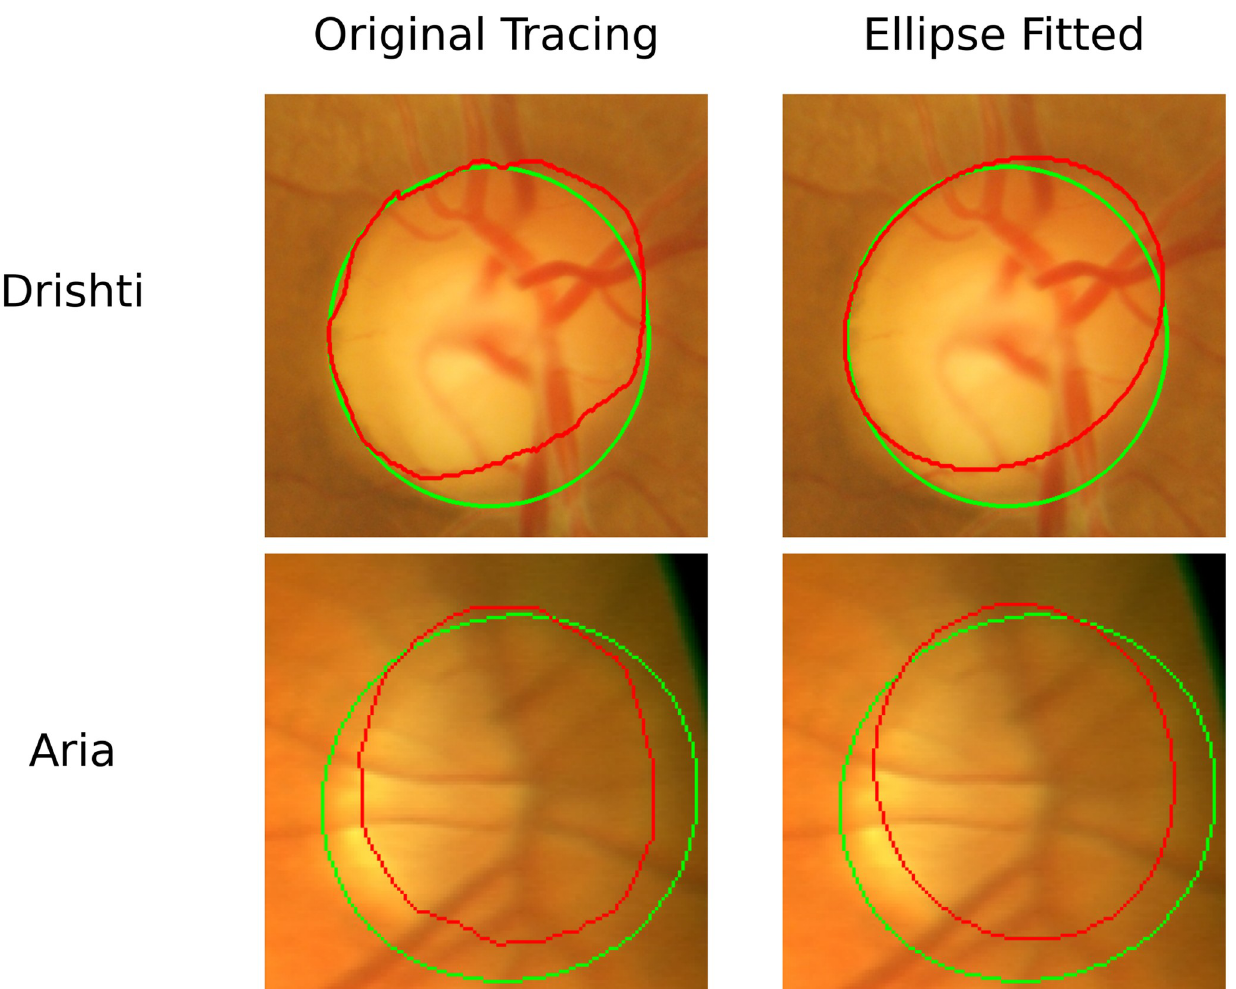
Fig 5. Images obtained from the Drishti and ARIA datasets showing ellipse fitting lead to lower precision in the traced disc region. The first row represents an image from the Drishti dataset before and after applying ellipse fitting. The second row is similar to the first one but for an image obtained from the Aria dataset. The green tracing represents the ground truth and the red represents the tracing performed by the optometrist. The application of Ellipse fitting led to a decrease of DC from 90.59% to 89.35% for the Drishti image from 86.28% to 84.73% for the Aria image.